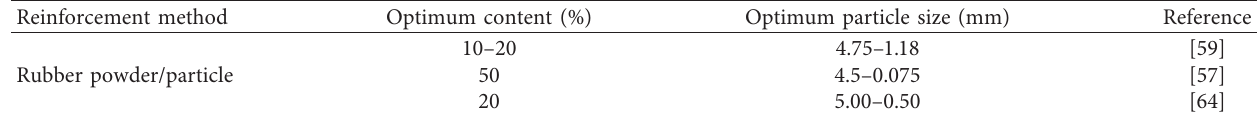
Table 3: Summary of reinforcing soil with rubber powder/rubber particles.